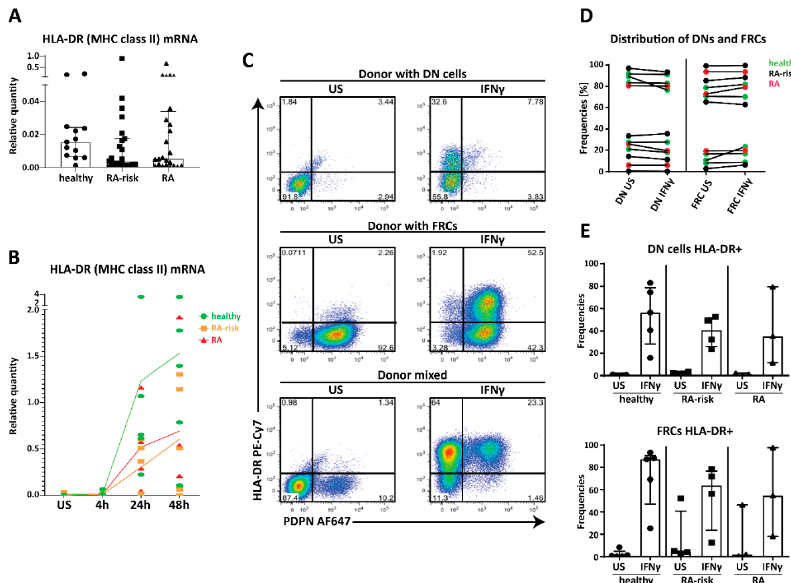
Figure 4. Expression of human leukocyte antigen-DR (HLA-DR) (major histocompatibility complex (MHC) class II) in cultured human LNSCs. ( A ) Expression of HLA-DR mRNA in cultured human